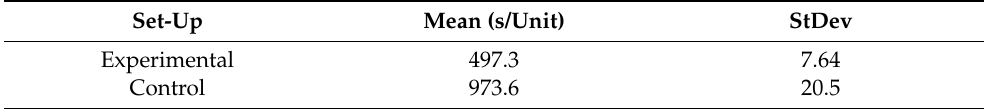
Table 12. Statistics for the roasting time per unit.